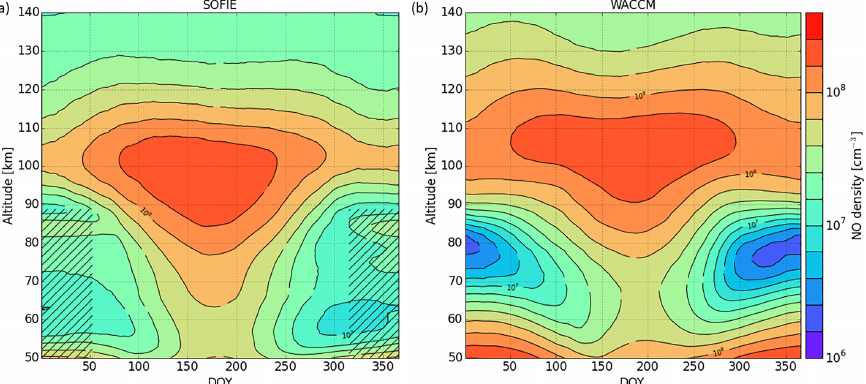
Figure 1. Seasonal climatology of Antarctic NO number density in SOFIE (a) and WACCM (b) . Data are smoothed with a 3-month running average. Hashed areas represent the Antarctic PMC season, during which SOFIE data should not be compared to the WACCM climatology (see more information in Sect. 2.1).